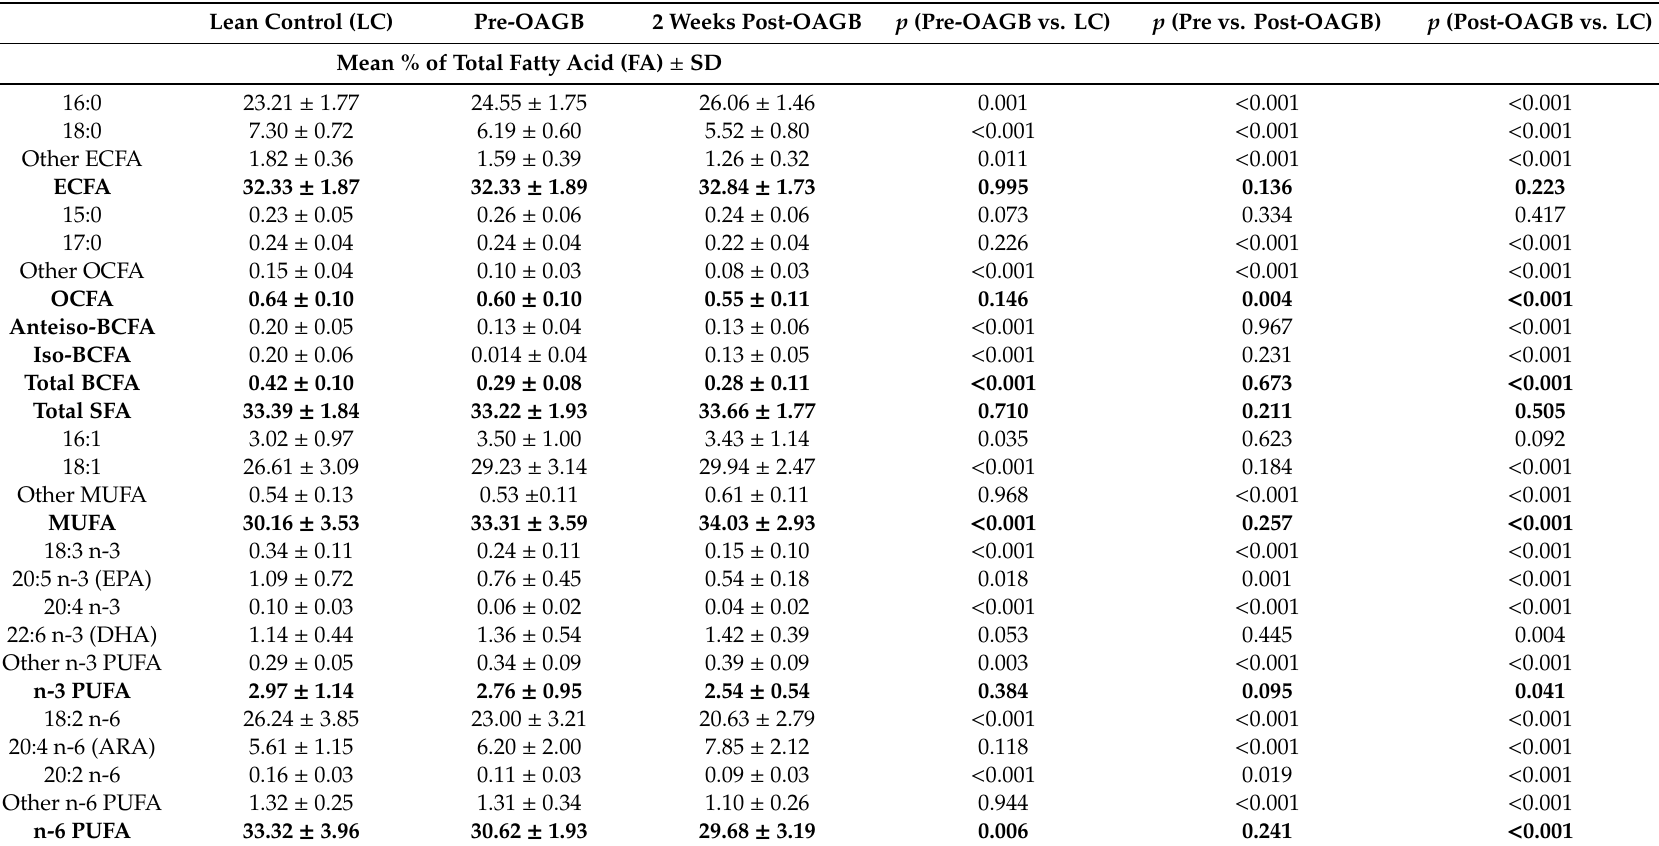
Table 2. Serum fatty acid composition (%) in lean controls and obese subjects before and two weeks after bariatric surgery. Lean Control